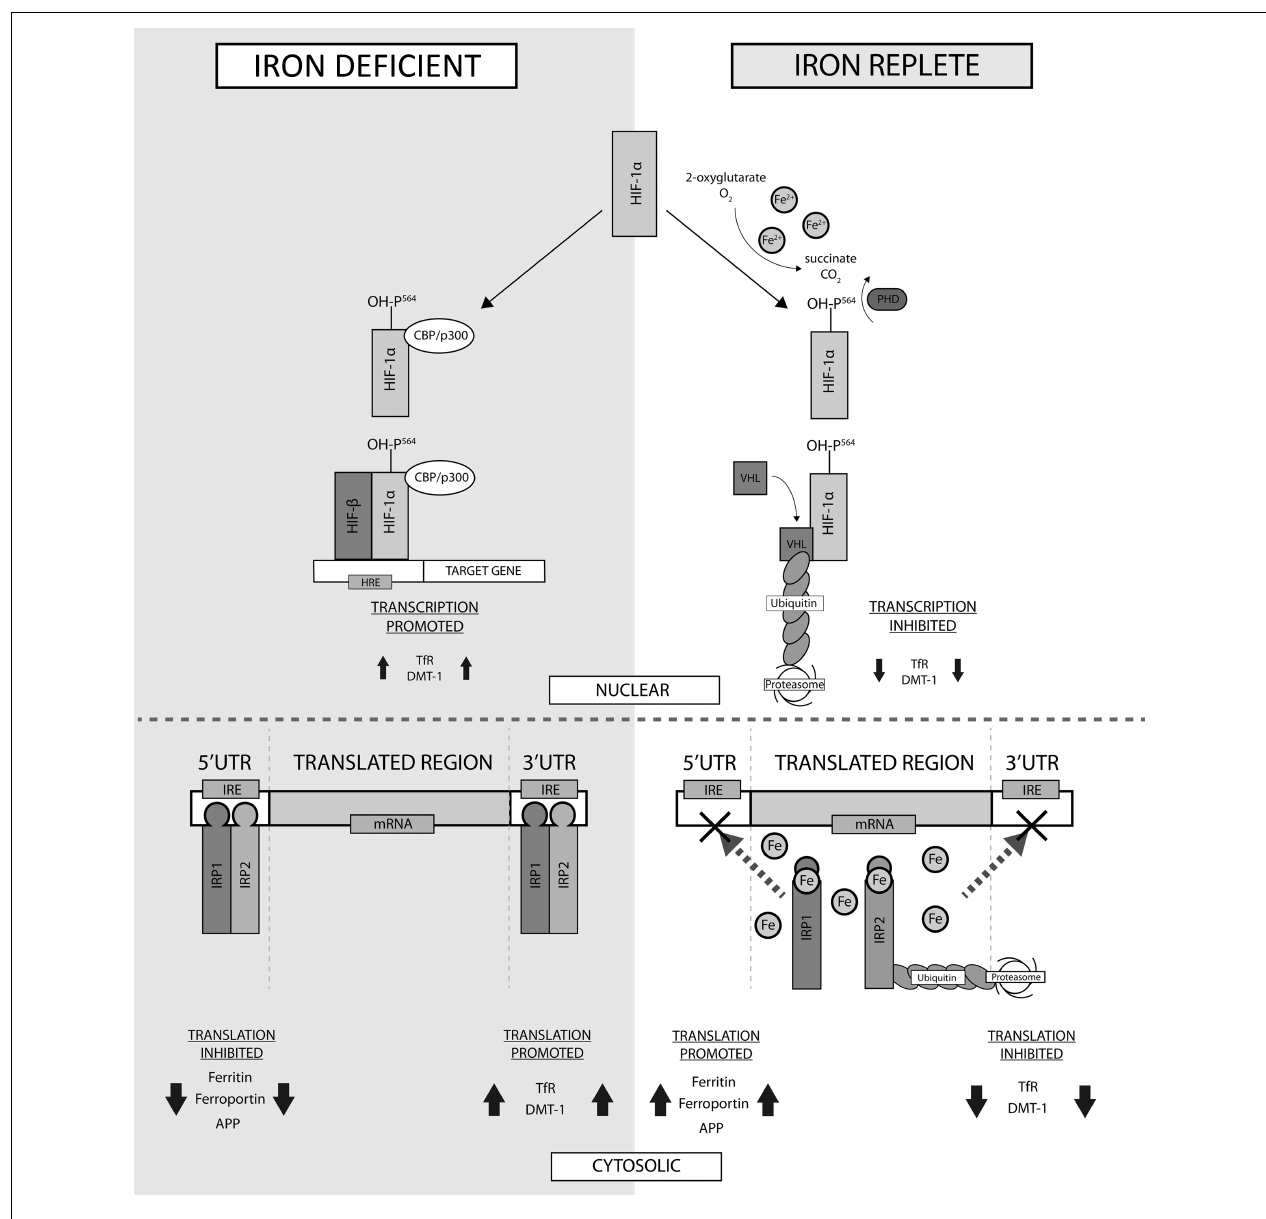
FIGURE 2 | Factors influencing cellular iron metabolism. Cellular oxygen homeostasis regulates iron metabolism in the nucleus via the hypoxia inducible factors (HIF-1 α and -1 β ). In normoxia conditions, Fe 2 + mediates the hydroxylation of proline residue 546 on HIF-1 α by prolyl-4-hydroxylase (PHD), which enables ubiquitination via binding with the von Hippel–Lindau tumor suppressor gene product (VHL). Decreased HIF-1 α inhibits transcription of proteins dictating iron uptake and export. In the iron-deficient cell, HIF-1 α instead interacts with CREB binding protein/p300 (CBP/p300) and forms a